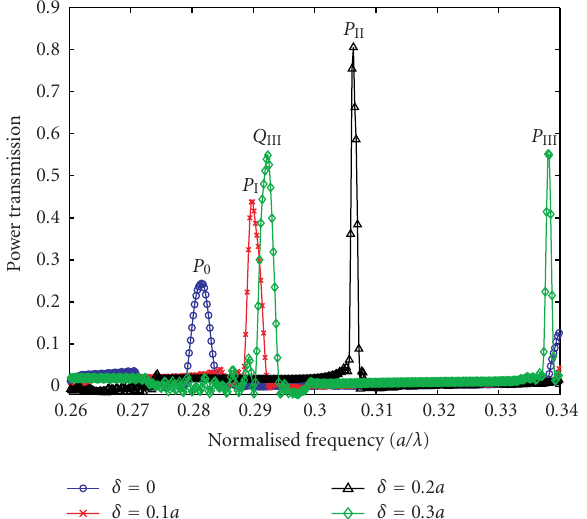
0 . 340 . 330 . 320 . 310 . 30 . 290 . 280 . 270 . 26